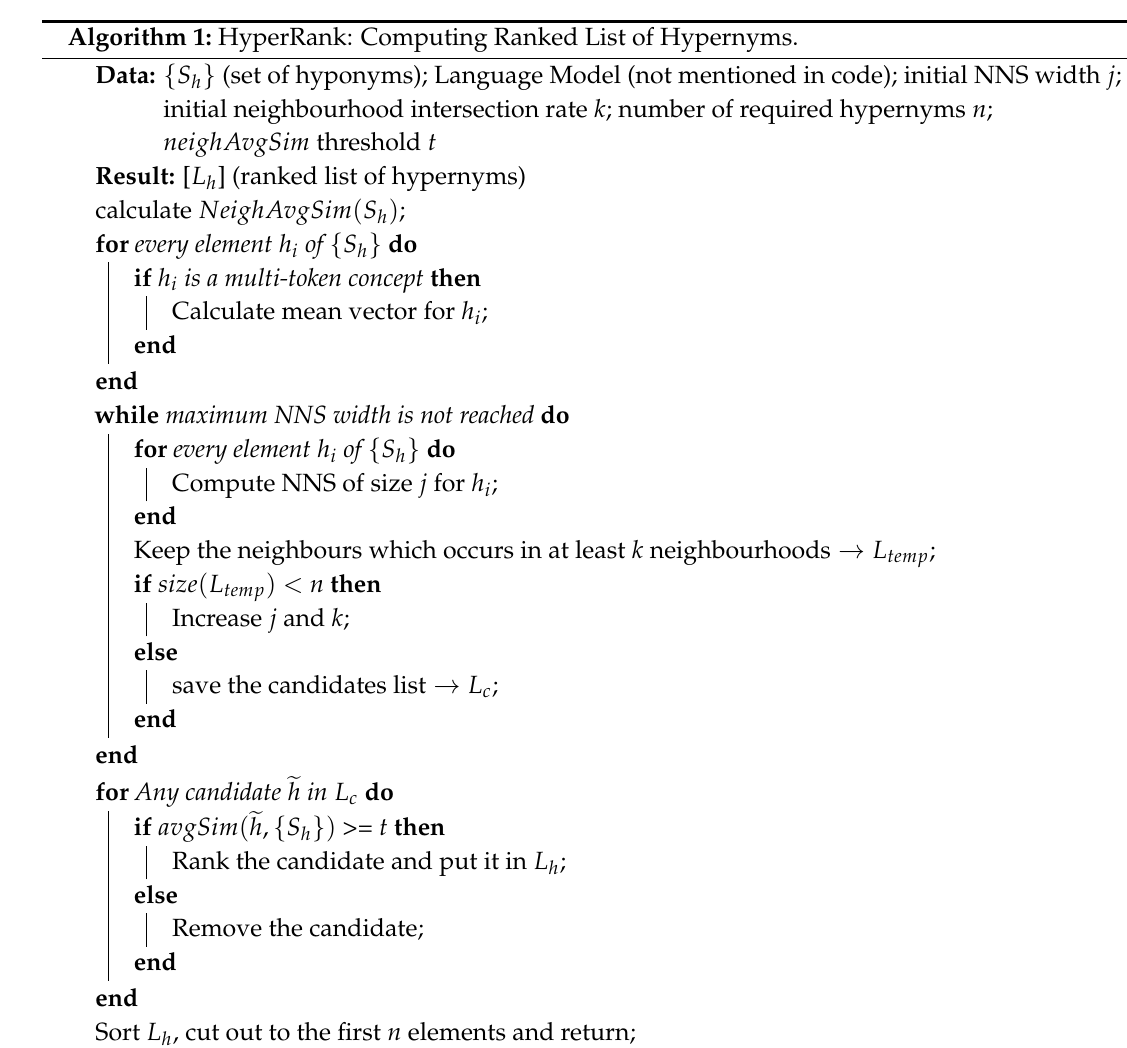
Table 1. The first three corpora contain general-purpose text in various